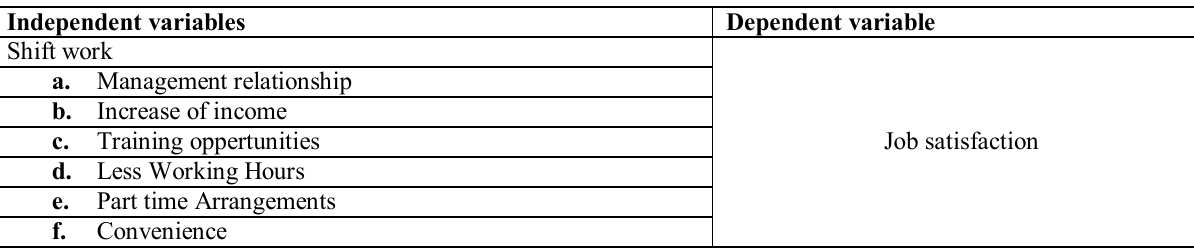
Table 1: Description of